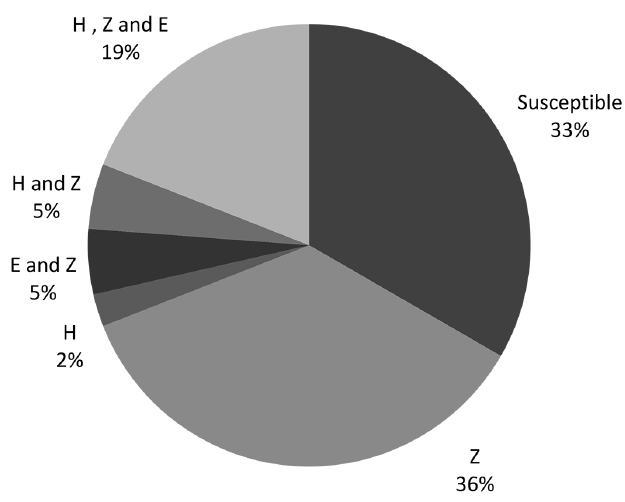
FIGURE 2 - Percentage of resistant strains by broth microdilution method. Isoniazid (H), pyrazinamide (Z), ethambutol